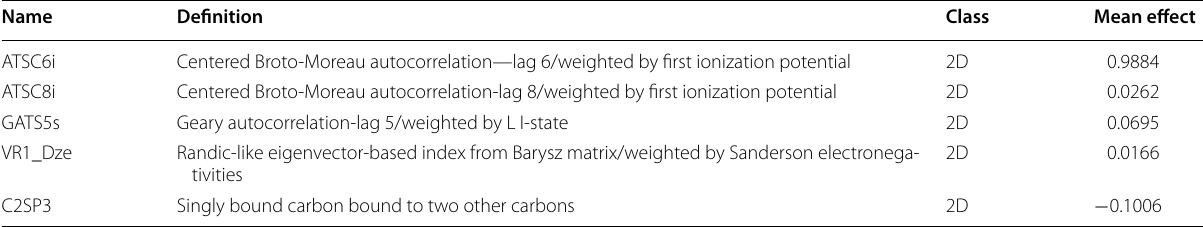
Table 10 Definition of descriptors and their classes for the model